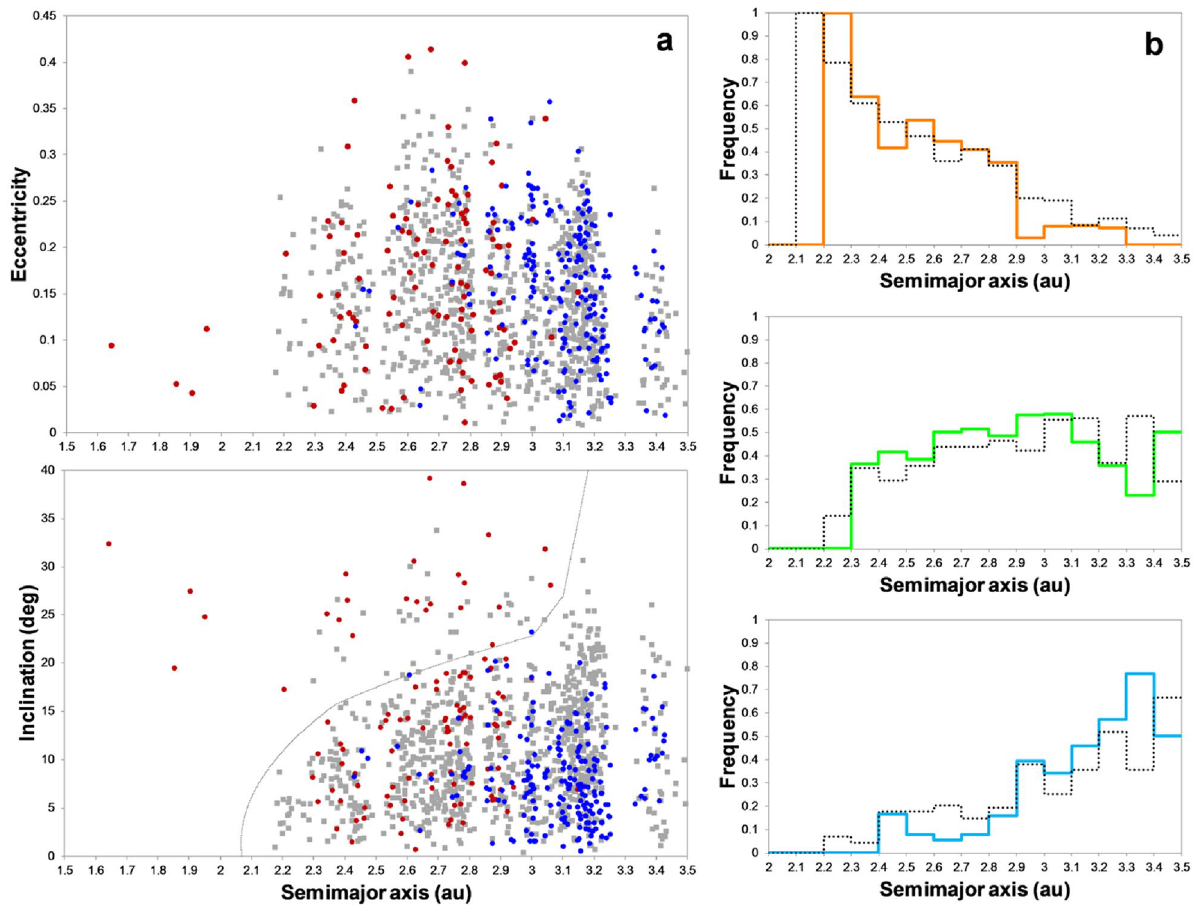
Figure 4. Comparison of our representative asteroid belt constructed based on disk models that yielded terrestrial planet systems analogous to our own (coloured symbols/curves) with 895 large observed asteroids not belonging to asteroid families (greyscale symbols/curves). Model asteroids represent the state after ~ 4.1 Gyr of dynamical evolution. Observed asteroids possess diameters D > 20–30 km (for albedos 0.1–0.2). ( a ) The representative asteroid belt consists of local primordial asteroids in the protoplanetary disk at < 3.5 au (brown symbols) and asteroids captured from trans-Jovian orbits after giant-planet migration (blue symbols). The proportion of local:captured asteroids is 33%:67%. The curve indicates the location of the secular resonance nu6 (bottom). ( b ) Both model and observed asteroids are classified as S- (top), C- (middle) and D/P-type asteroids (bottom). The histograms show the relative fractions of asteroid types per semimajor axis bin. The composition model considered the following proportions of S-, C-, D/P-asteroids: S80%-C20% (< 2 au) and S50%-C50% (> 2 au) for local and S5%-C47.5%-DP47.5% for captured asteroids. See Methods and Supplementary Information for